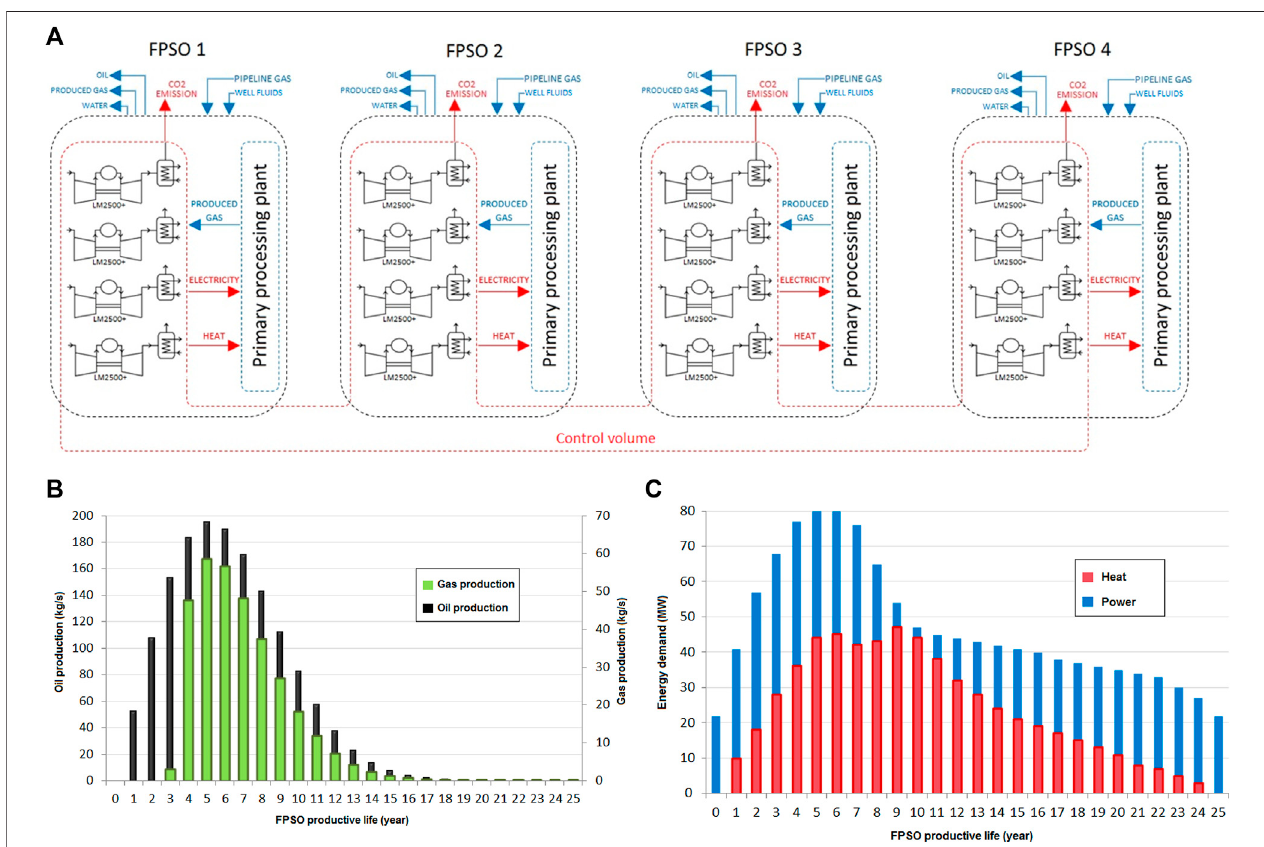
FIGURE 1 | Standalone FPSOs: (A) Cogeneration and processing plants (Freire et al., 2020); pro fi les of (B) production and (C) energy demands of one FPSO. Based on data from Freire et al. (2020).